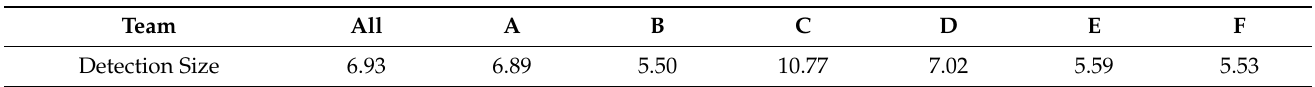
Table 5. POD analysis results of each team for the detectable length with 80% probability [mm].